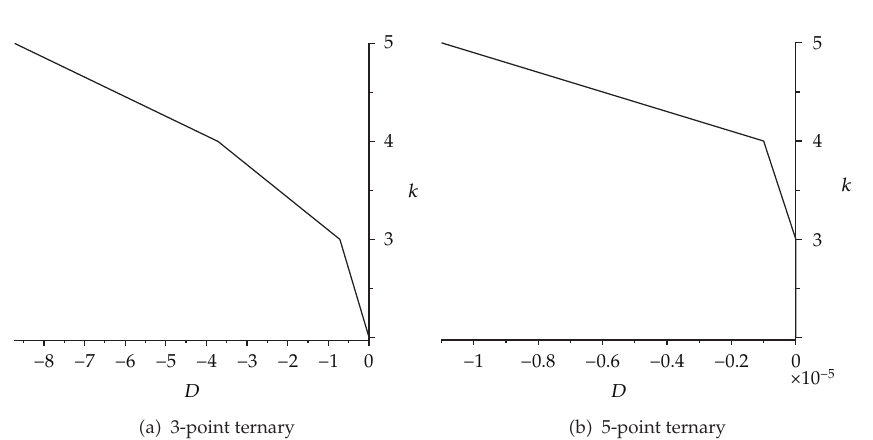
Figure 5: Presents measure of deviation of convexity of 3-point and 5-point ternary interpolating scheme.